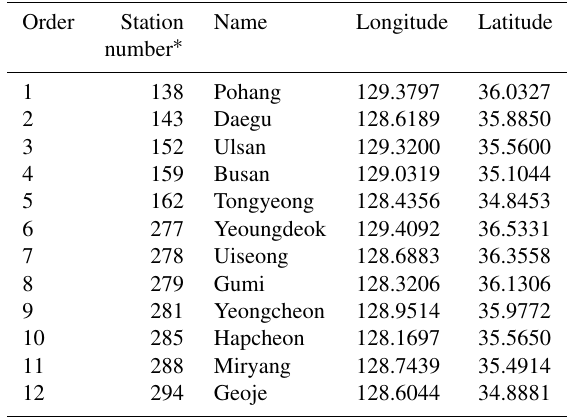
Table 1. Information on 12 selected stations from the Yeongnam province, South